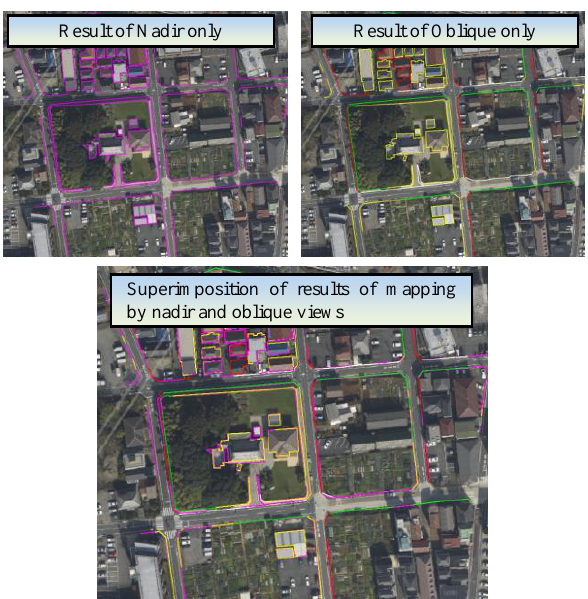
Figure. 15 Result of accuracy verification Superimposition of results of mapping by nadir and oblique view